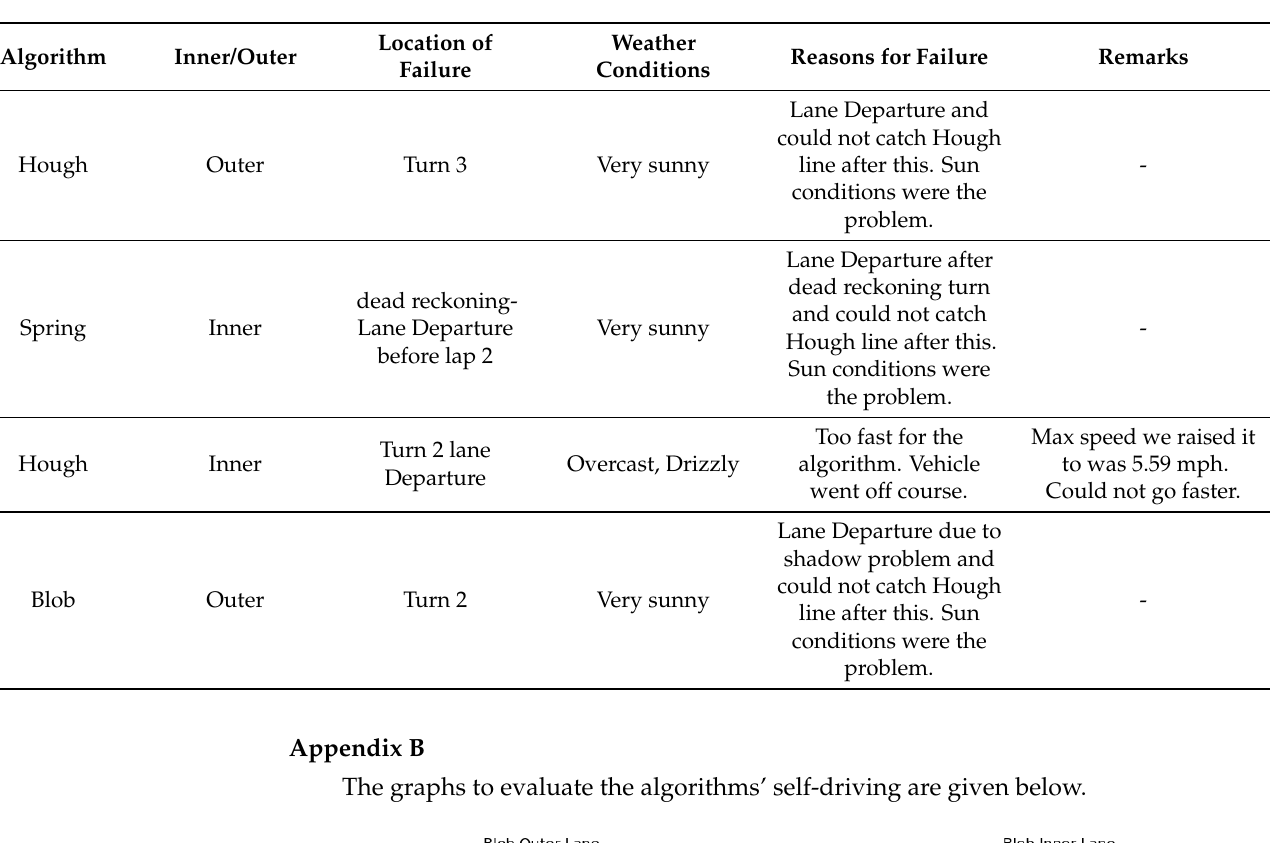
Table A4. Failure Cases recorded when evaluated by a team member.